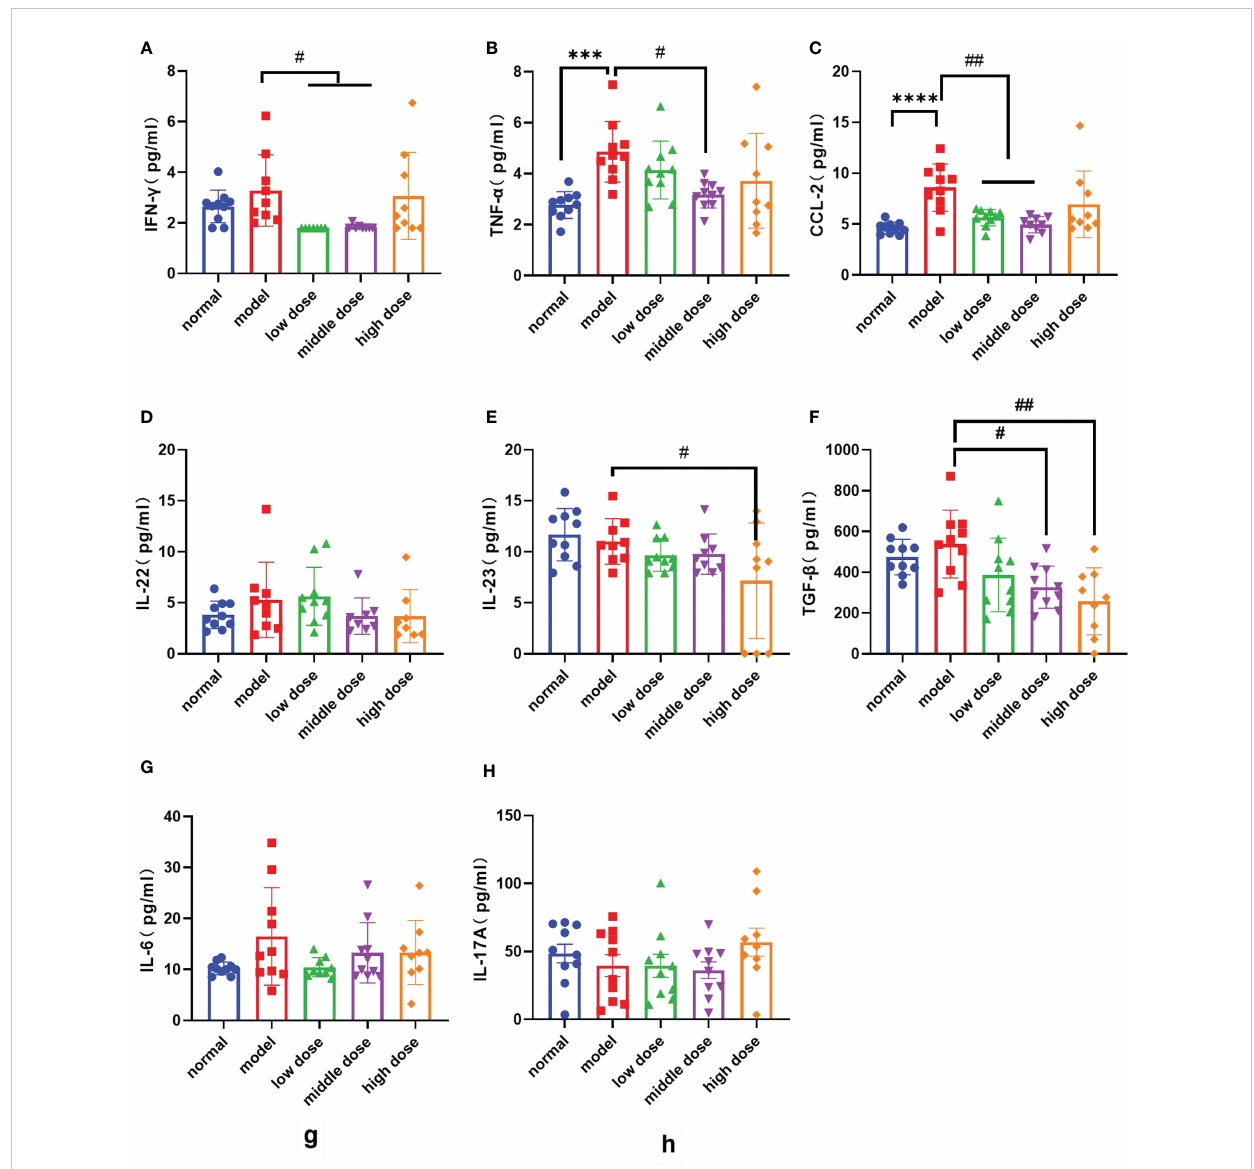
FIGURE 7 The levels of various factors in the serum of mice in each group at the 20th week, (A) : IFN- g levels; (B) : TNF- a levels; (C) : CCL-2 levels; (D) : IL-22 levels; (E) : IL-23 levels; (F) : IL-17A levels; (G) : IL-6 levels; (H) : TGF- b levels. Data are presented as mean ± SD; ***p ≤ 0.001, ****p ≤ 0.0001 vs. Normal; # p ≤ 0.05, ## p ≤ 0.01, vs. Model; In model group, low dose group, middle dose group, n=10; in high dose group, n=9. Outliers were removed using the ROUT (Q = 1%) method, IFN- g : model (9), low dose (5.68, 4.32, 2.36), middle dose (2.28, 2.47); IL-22: model (23.85), middle dose (8.94), high dose (17.64); IL-23: model (24.38), middle dose (20.16); IL-6: low dose (32.46); IL: interleukin; TGF ‐ b 1: transforming growth factor beta 1; CCL-2: The chemokine (C-C motif) ligand 2; IFN- g : Interferon